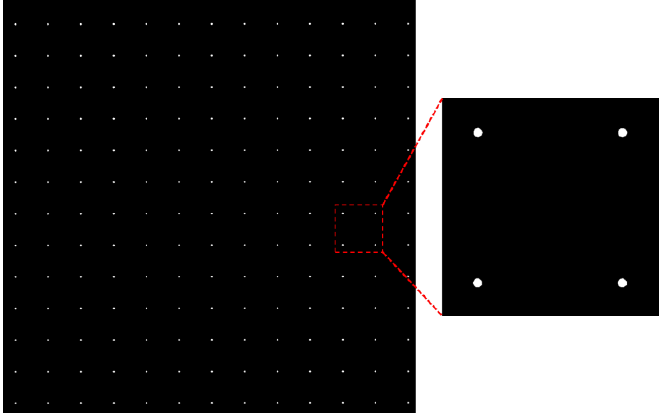
Figure 5. Results of binary-thresholding followed by the opening from the correlation map.